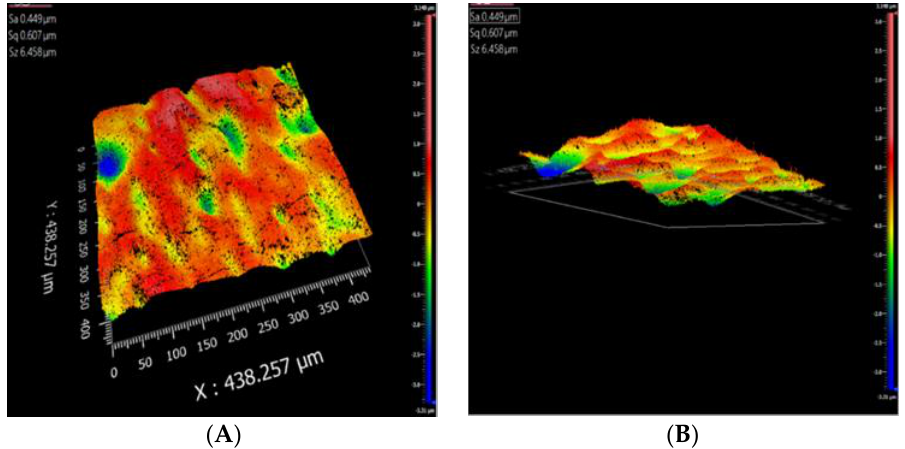
Figure 9. ( A ) Three-dimensional- and ( B ) bottom-view of phosphorene membranes showing the surface morphology .